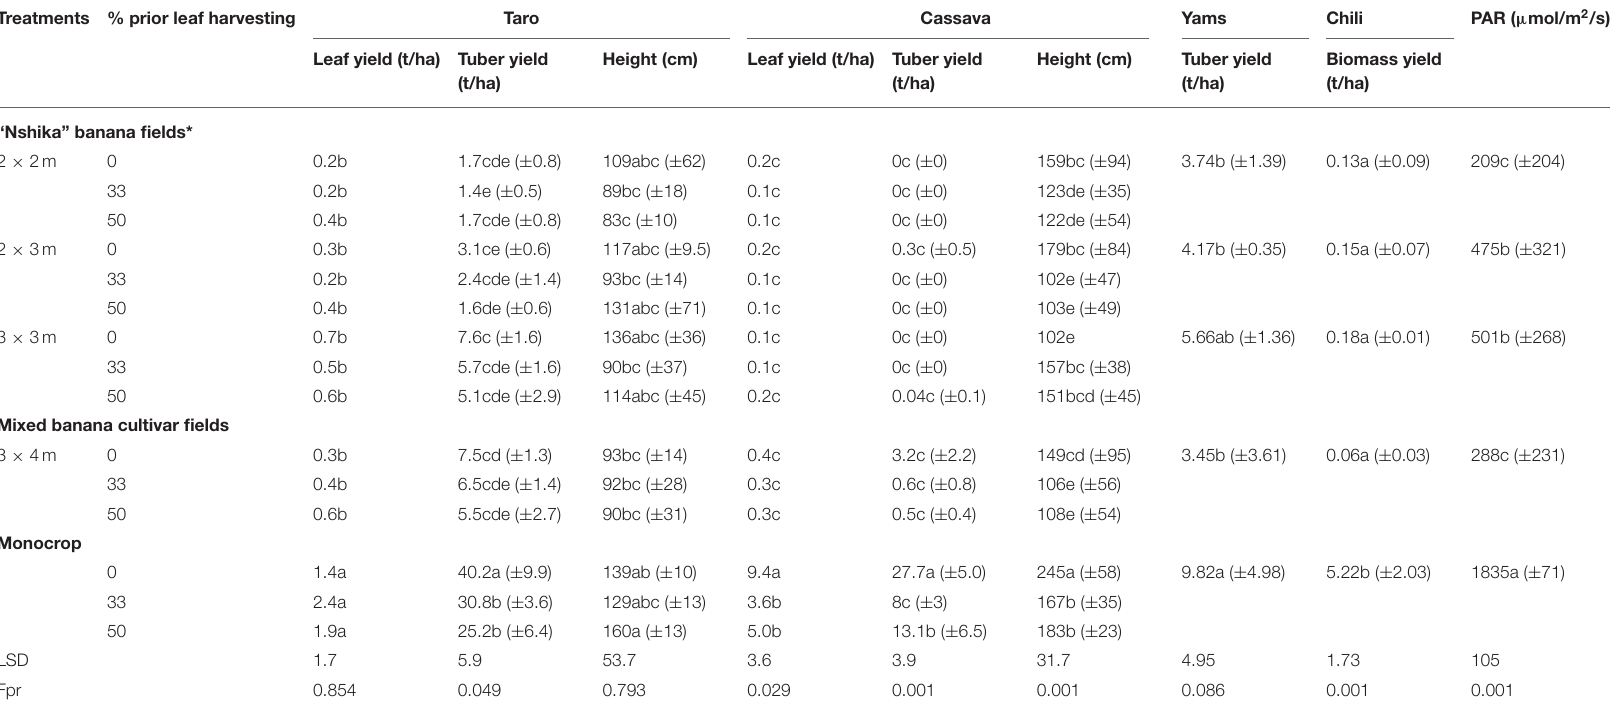
TABLE 2 | Yield and growth attributes of crops grown at the Katana center: tuber crops taro (variety “Ishikazi”), cassava and yam and spice crop chili. Treatments % prior leaf harvesting Taro Cassava Yams